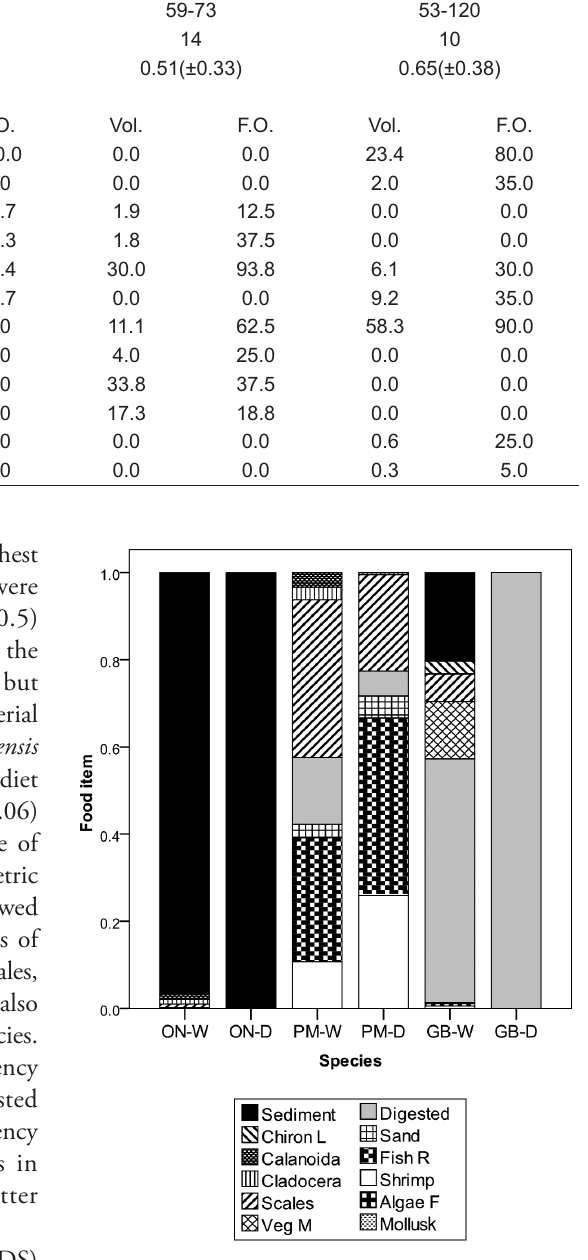
Figure 1. Proportional composition of food items to the diet of O. niloticus (ON), P. managuensis (PM) and G. brasiliensis (GB) during the wet (W) and dry (D) periods. See Table 1 for full food items